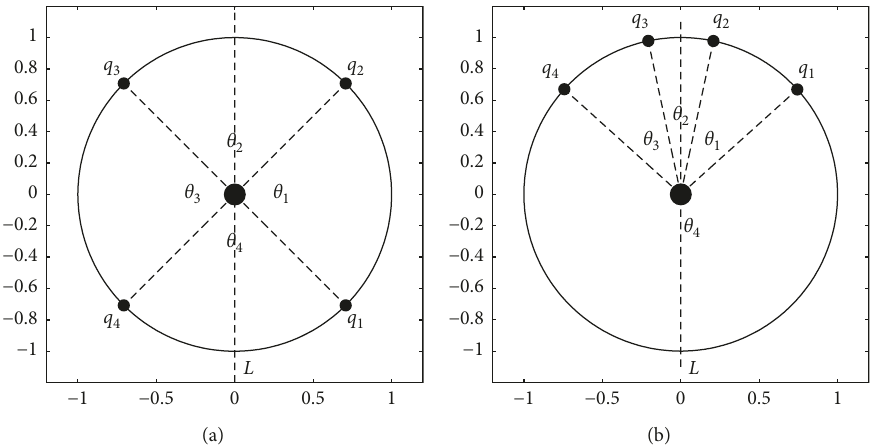
Figure 3: Central configurations for the 1+4 body problem with θ Proposition 1. (b) The only central configuration according to Theorem